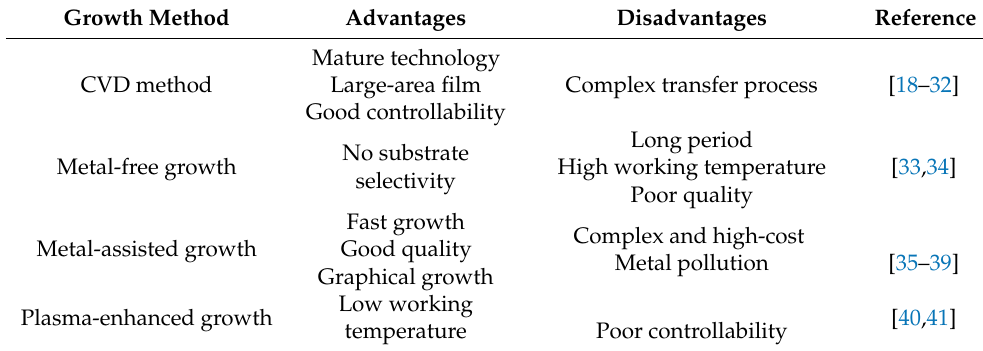
Table 1. Comparison of advantages and disadvantages of graphene growth methods. Growth